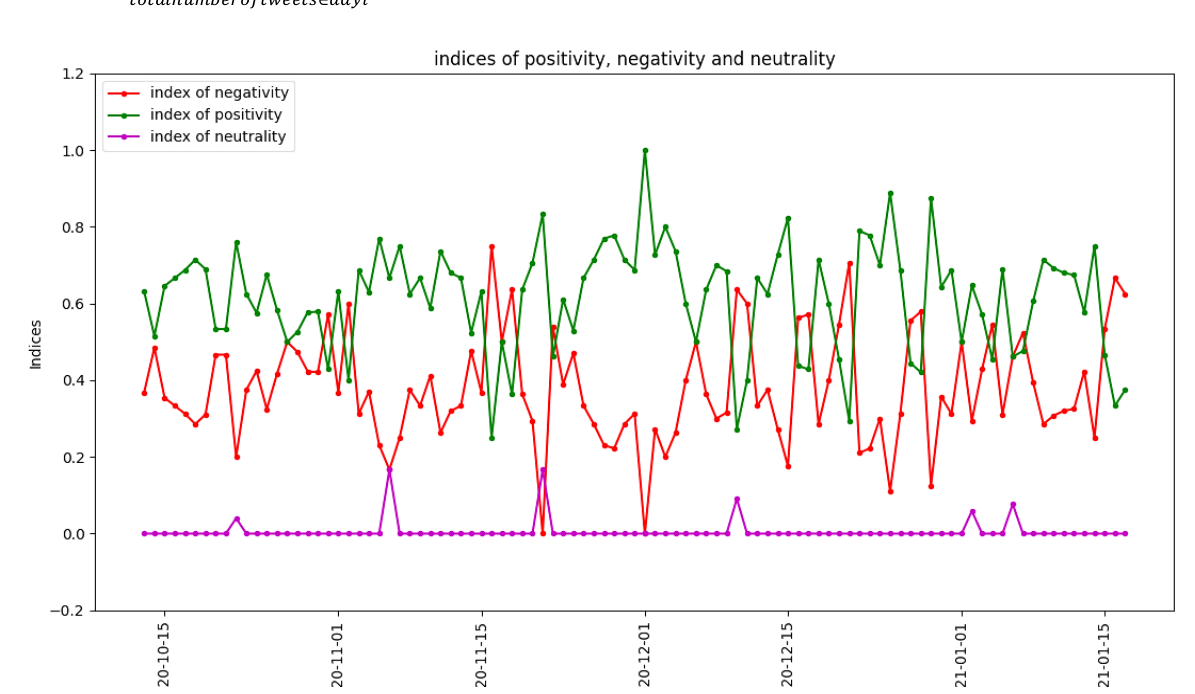
Figure 1. Indices of positivity, negativity and neutrality